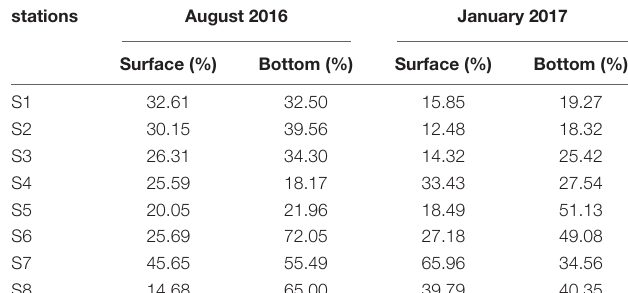
TABLE 2 | Contribution of CSP-N to PN in the Pearl River estuary during August 2016 and January 2017 cruise. stations